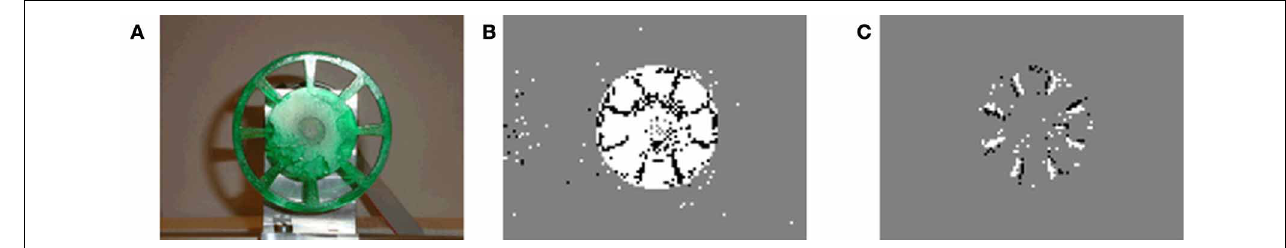
FIGURE 1 | Wheel spinning at 3000rpm. (A) Still image. (B) Events generated in 30ms: ON events rendered white, OFF events in black. (C) Events generated in 200us.